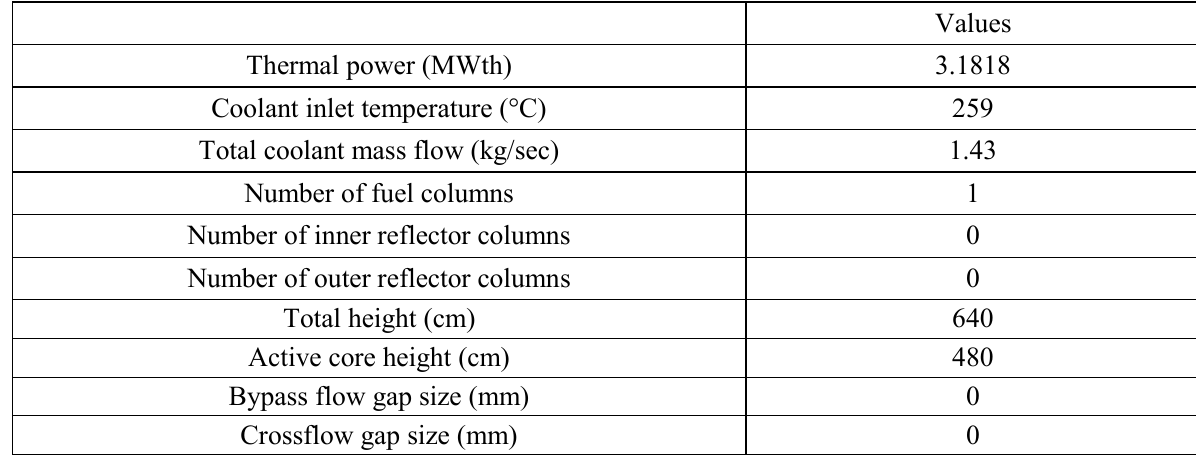
Figure 4. Geometry of Single Column Problem. Table I. Problem conditions of the single column